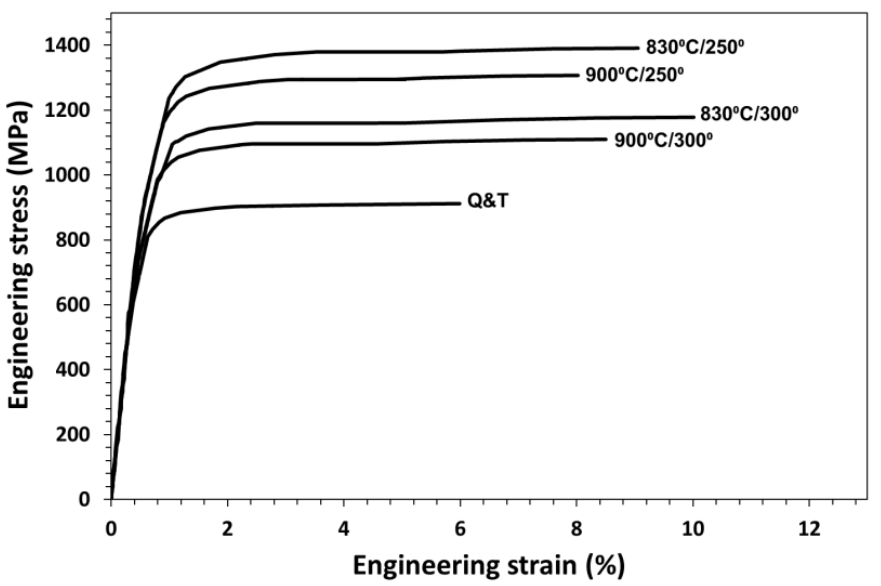
Figure 12. Engineering stress–strain curves at room temperature, of microstructures obtained after transformation at the temperatures indicated.